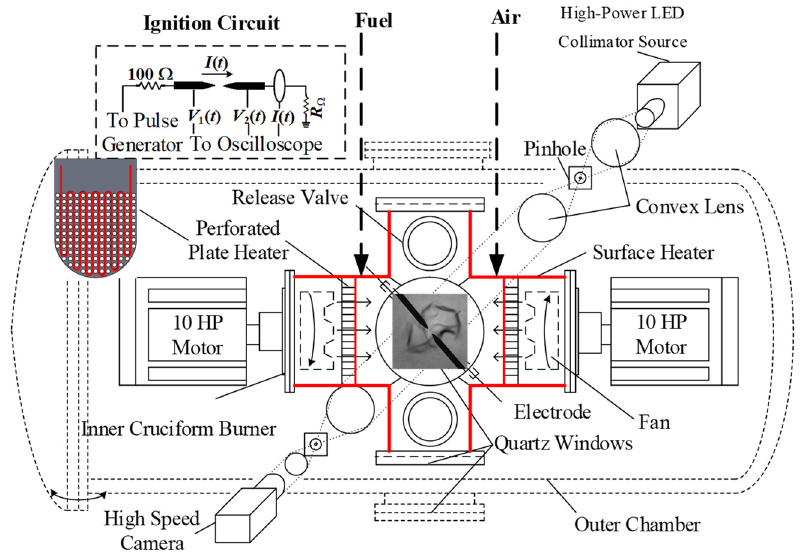
Figure 1. The simplified sketch of a dual-chamber, constant temperature/pressure, fan-stirred explosion facility capable of generating near-isotropic turbulence alongside the schlieren imaging arrangement and the schematic ignition circuit. A typical enlarged schlieren image of the turbulent expanding flame is inserted in the experimentation domain (the central quartz window) to show the electrodes and the successful ignition event.